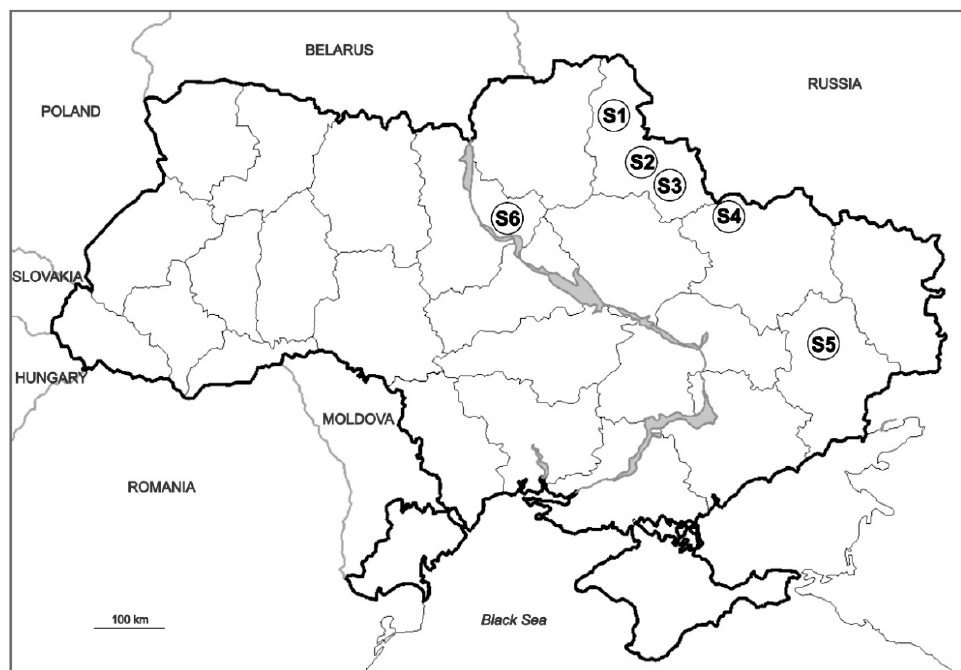
Figure 1. Map of Ukraine showing study sites denoted by S1–S6.